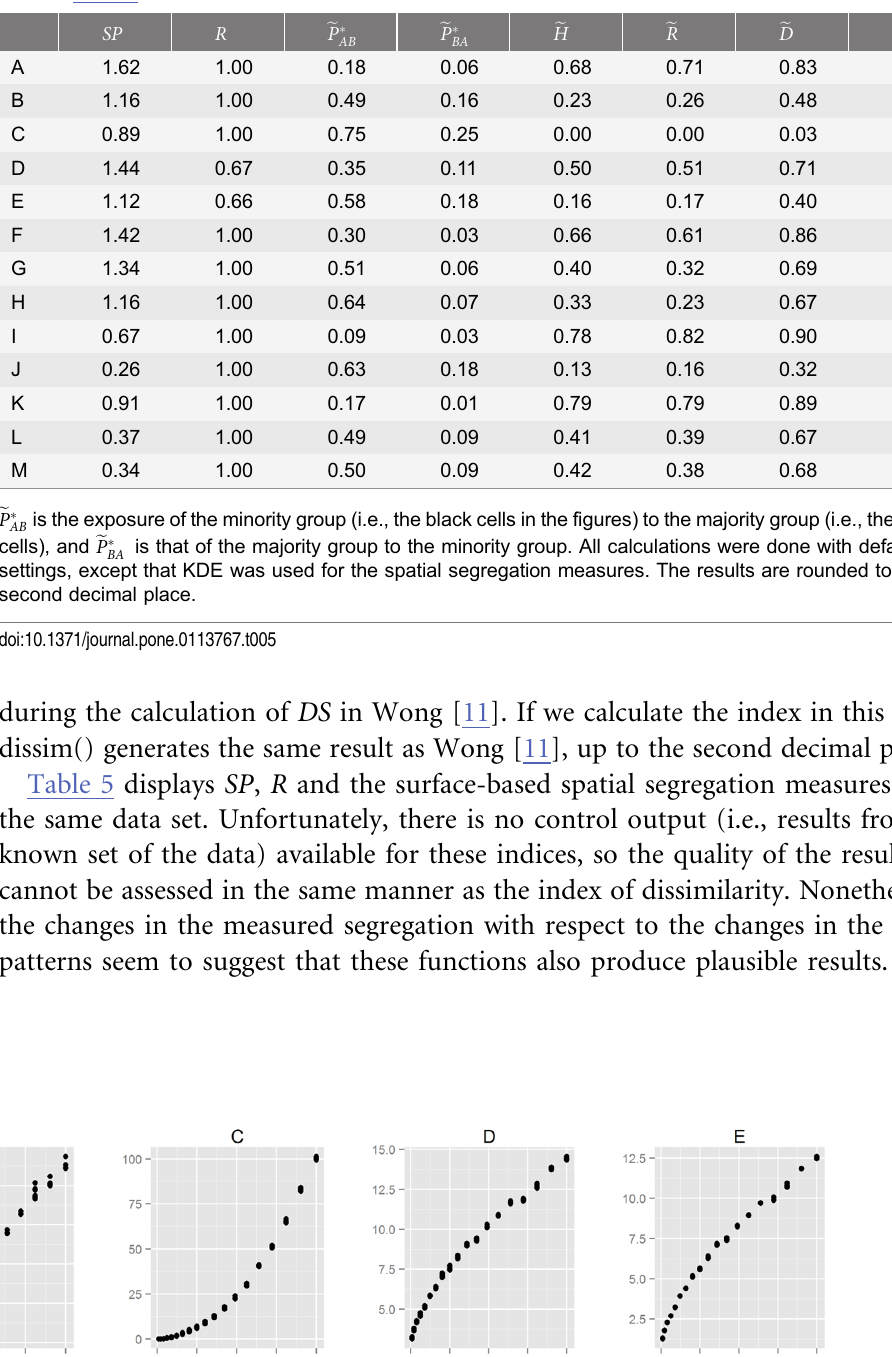
Table 5. SP , R and the surface-based spatial segregation measures for the hypothetical segregation patterns listed in Table 3. SP R e P (cid:2) AB